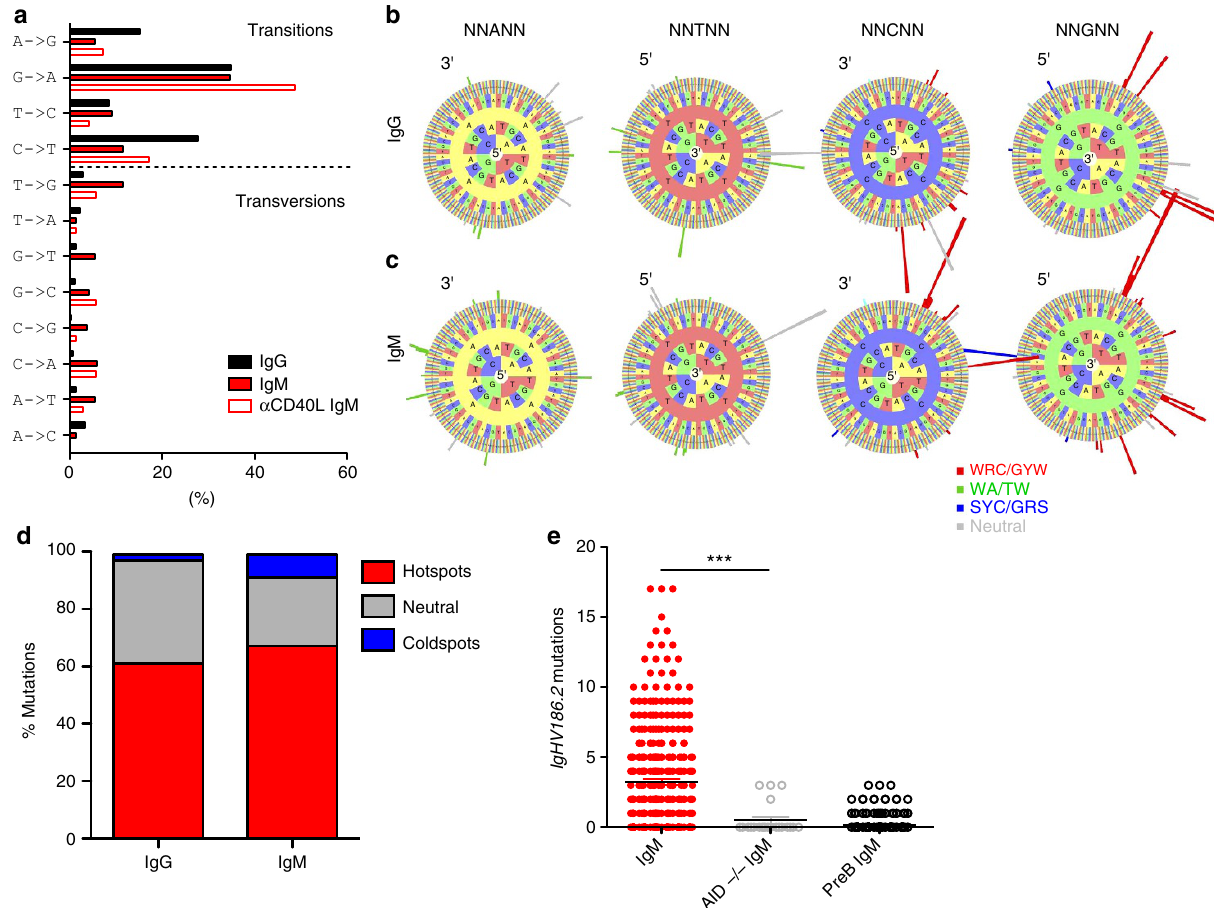
Figure 4 | IgM heavy chain mutations are AID-induced and AID-dependent. ( a ) Frequency of transition and transversion mutations for IgG (filled black square) and IgM PCs, with (open black square) or without (filled red square) a CD40L GC depletion. ( b , c ) Individual 5-mer mutabilities estimated from IgG and IgM sequences, respectively. Bars represent mutabilities of the central base as a function of the surrounding bases, read 5 0 –3 0 . Green (WA/TW) and red (WRC/GYW) bars indicate hotspot motifs, grey indicates the neutral sites and blue indicates the coldspots (SYC/GRS). Analysis was performed on total IgHV186.2 sequences for each population. ( d ) Percentage of total mutations found hotspot motifs (WRC/GYW or WA/TW) in red, neutral sites in grey, or coldspot motifs (SYC/GRS) in blue for IgG and IgM sequences. ( e ) IgM IgHV186.2 sequence mutations in cohorts of C57/BL/6 (filled red circles, n ¼ 4) or AID (cid:2) / (cid:2) (open grey circles, n ¼ 3) mice post-NP 22 CGG immunization, compared with total heavy chain sequences from pre-B-cell unmutated controls (open grey circles) isolated from immunized C57/BL/6 cohorts. Spleen and bone marrow PCs are pooled; and Student’s t -test * P o 0.05 and *** P o 0.001. Refer to Supplementary Table 1 for sequence